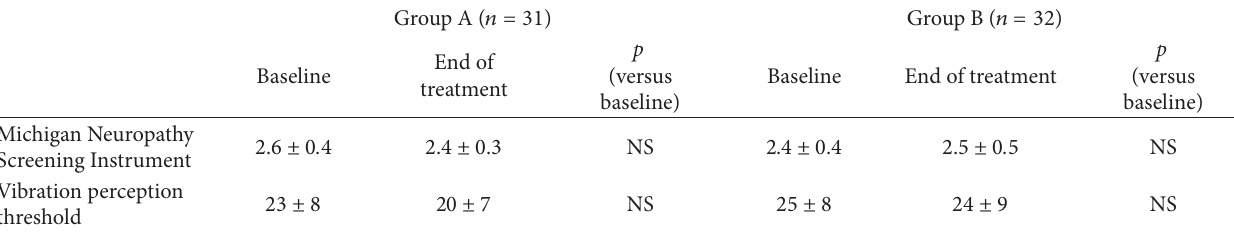
Table 3: Changes in indices of diabetic peripheral neuropathy during the study in patients who received quinapril (group A) and in those who did not (group